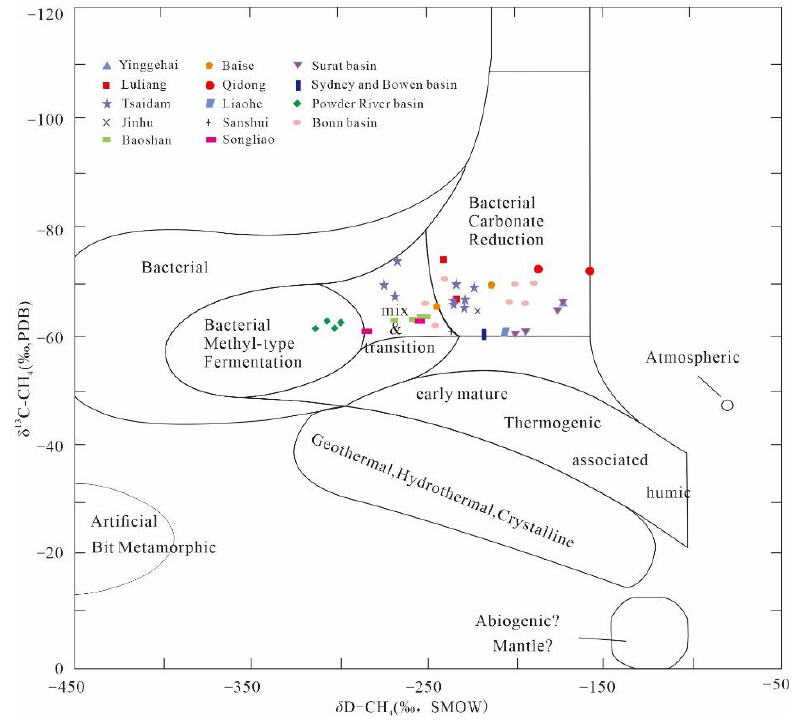
Figure 2. Genetic discrimination of coalbed methane (Adapted from [48,64 – 67]).